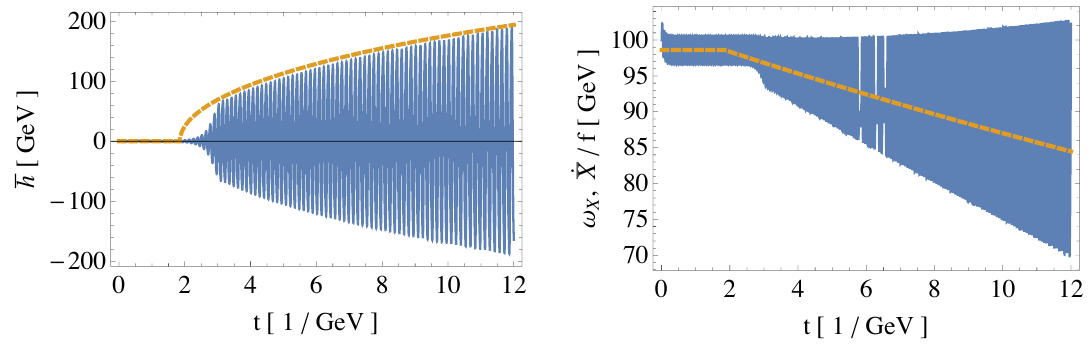
Figure 2 . A comparison between a numerical solution to eqs. (4.1) and (4.2) and the analytic result given in eqs. (4.21) and (4.22). Left: the blue line shows (cid:22) h and the orange line shows A h . Right: the blue line shows _(cid:22) X=f and the orange line shows ! X